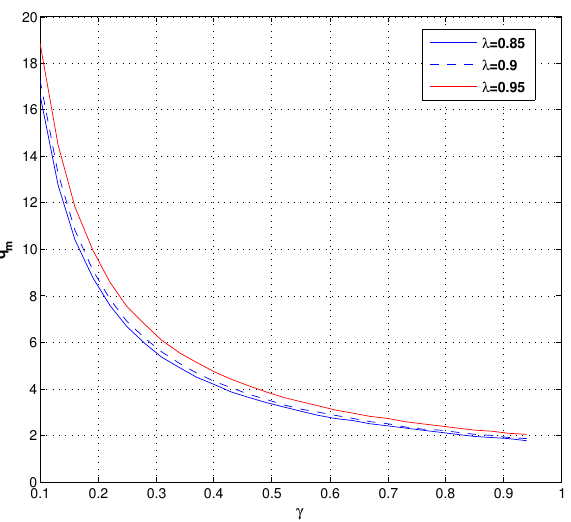
Figure 6. The optimal lot size of the manufacturer under different λ .